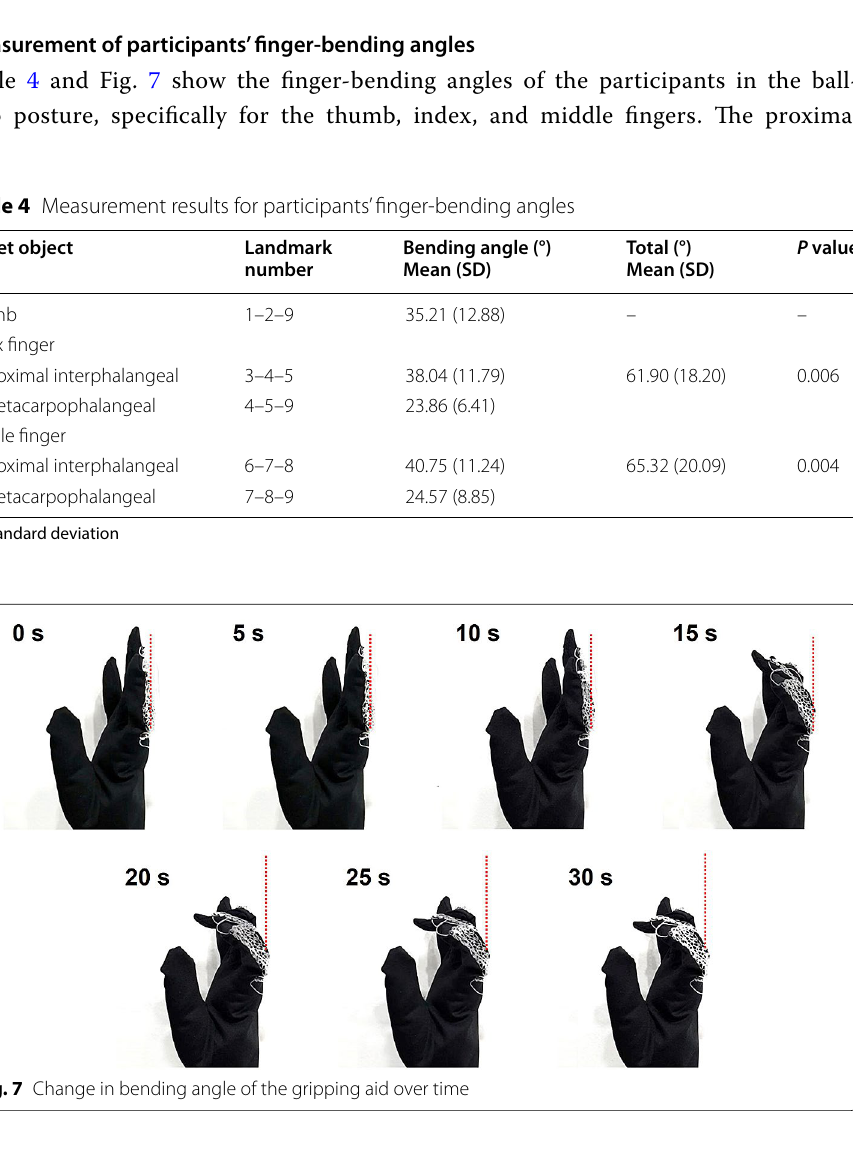
Fig. 7 Change in bending angle of the gripping aid over